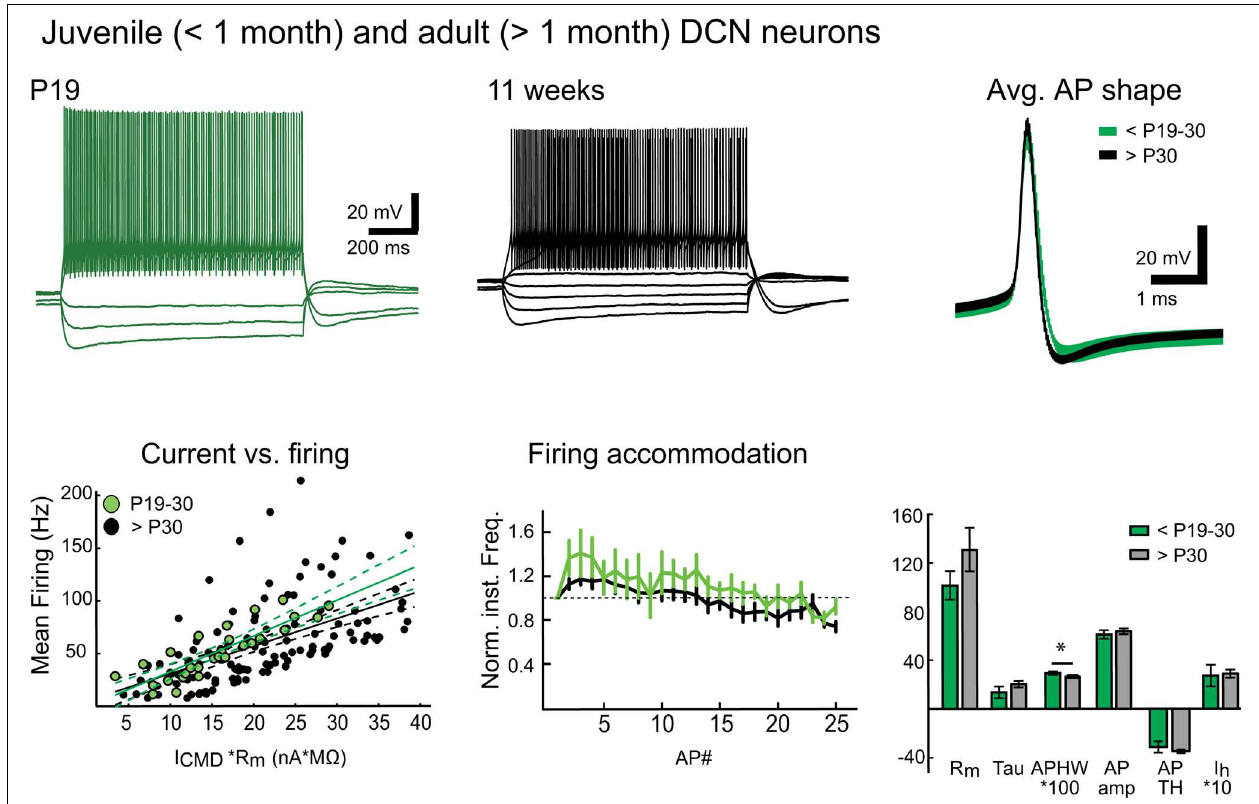
− 44.9 ± 1.7 mV; AHP: young: 24.0 ± 6.7 mV; old: 22.5 ± 1.2 mV; I h -sag: young: 27.2 ± 8.9 mV, old: 28.9 ± 3.4 mV; P value for each data group > 0.05). However, a slight decrease in mean AP half-width (APHW: young: 0.3 ± 0.01 ms; old: 0.26 ± 0.01 ms; P = 0.04) was, however, seen, possibly reflecting final maturation of the neuronal population. N = 5 GADnL neurons in young animals, 23 in old. Abbreviations: R m , input resistance; AP, action potential; APHW, action potential half-width; I CMD , step command current; C m , estimated neuronal capacitance (see methods). For averaged AP shapes, the thickness of the trace signifies ± SEM. Note that for correct comparison of current-to-firing relationships between neurons of possibly differing membrane resistances, the command current (ICMD) in bottom left panel is scaled by multiplying by with the measured R m for each cell. Also note that in the bar graphs (bottom right), values for APHW and I h -sag have been scaled (100 × and 10 × , respectively) for visual